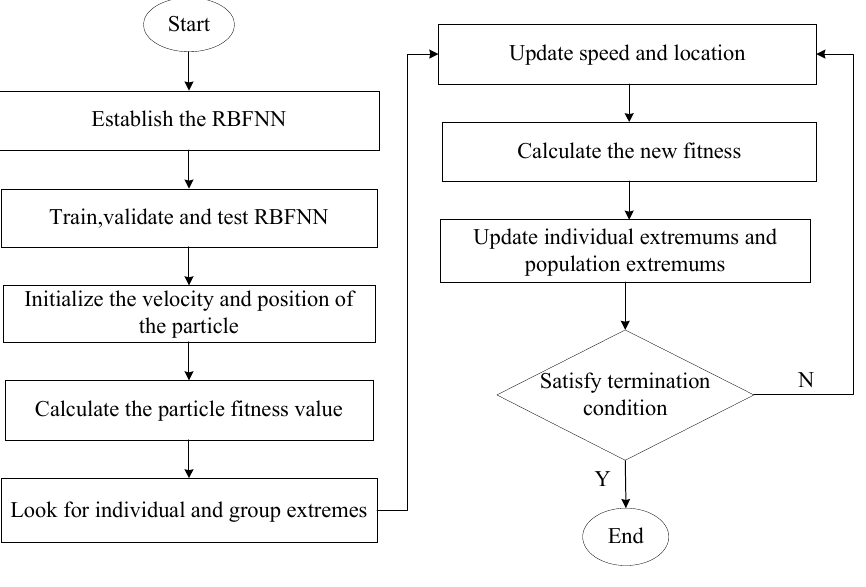
Figure 3. Optimization flow chart based on PSO.